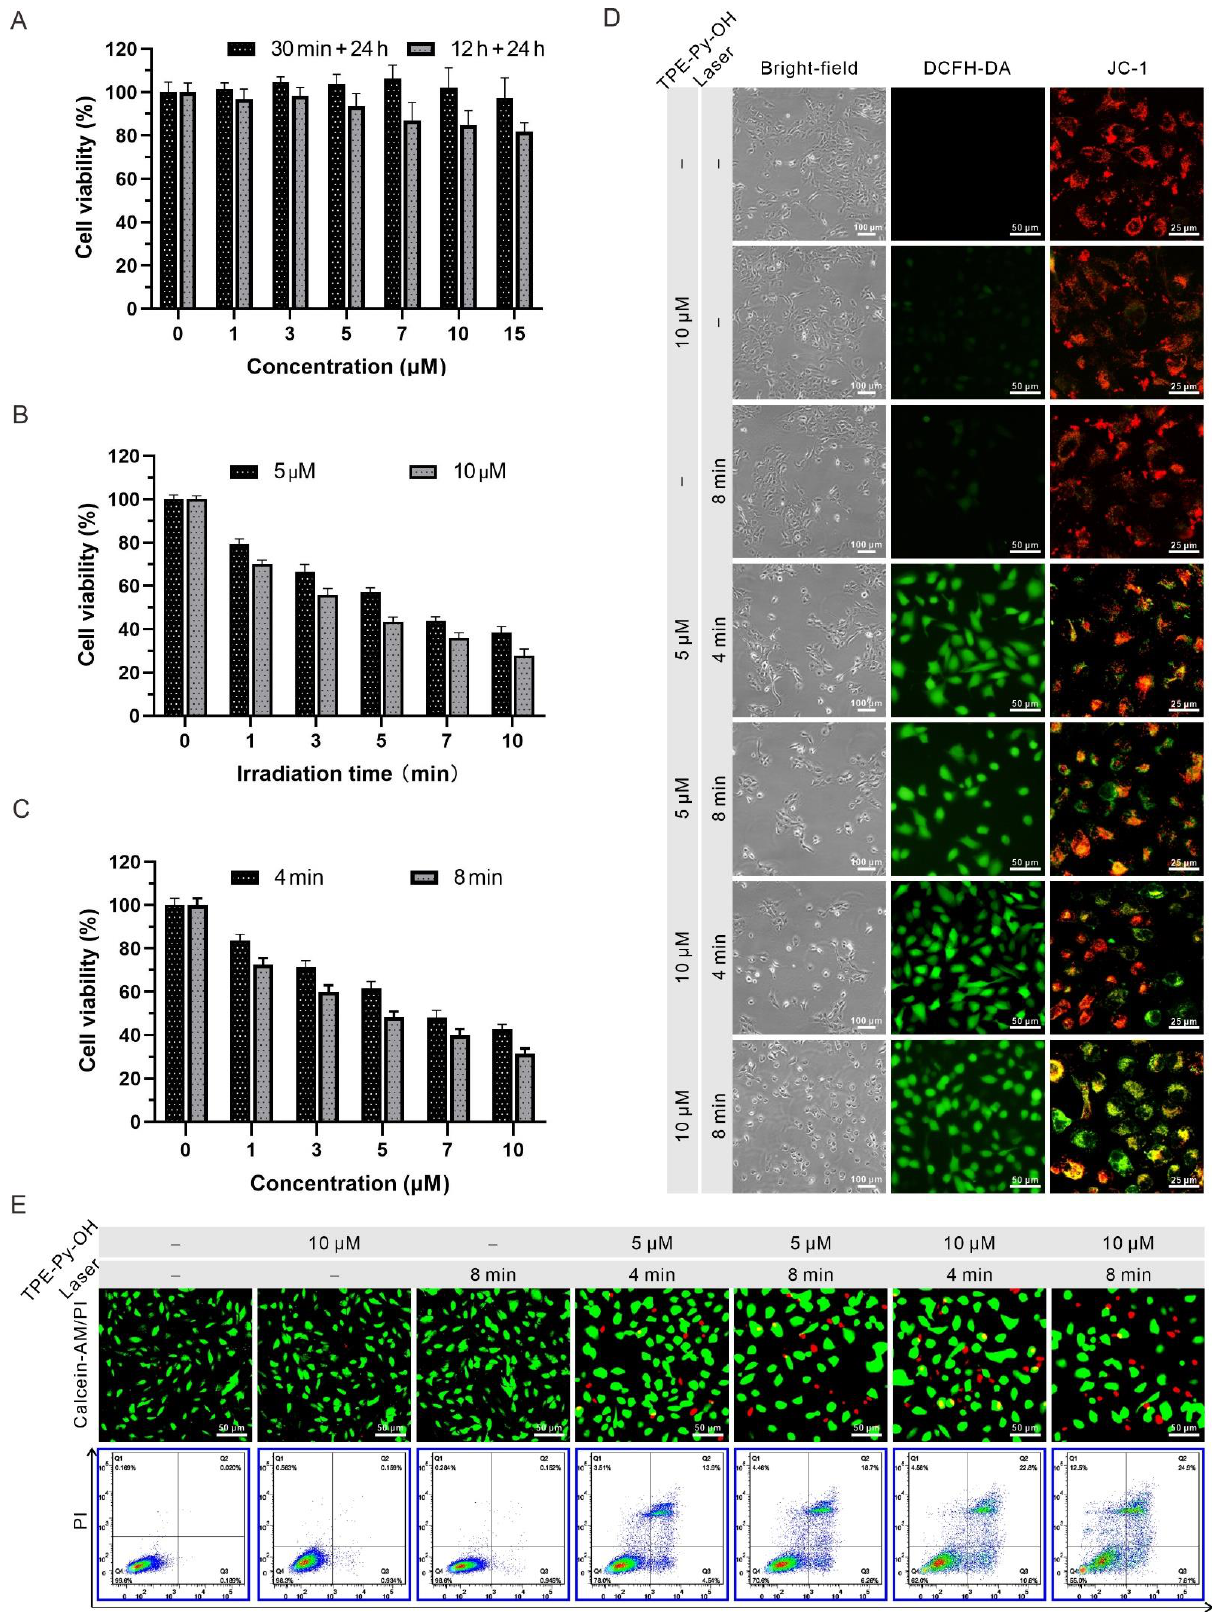
Figure 3. In vitro ROS generation and anti-tumor efficacy of TPE-Py-OH. ( A ) The viability of